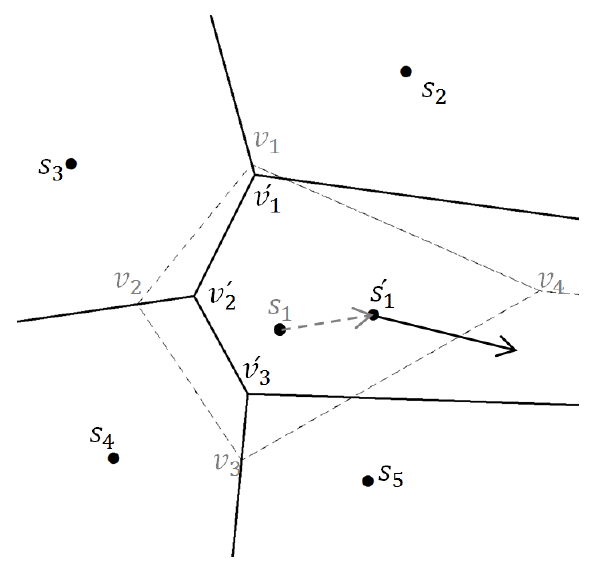
Figure 7. Moving direction and distance changes during the optimization process, dashed line represents the first step of the optimization, and solid line the